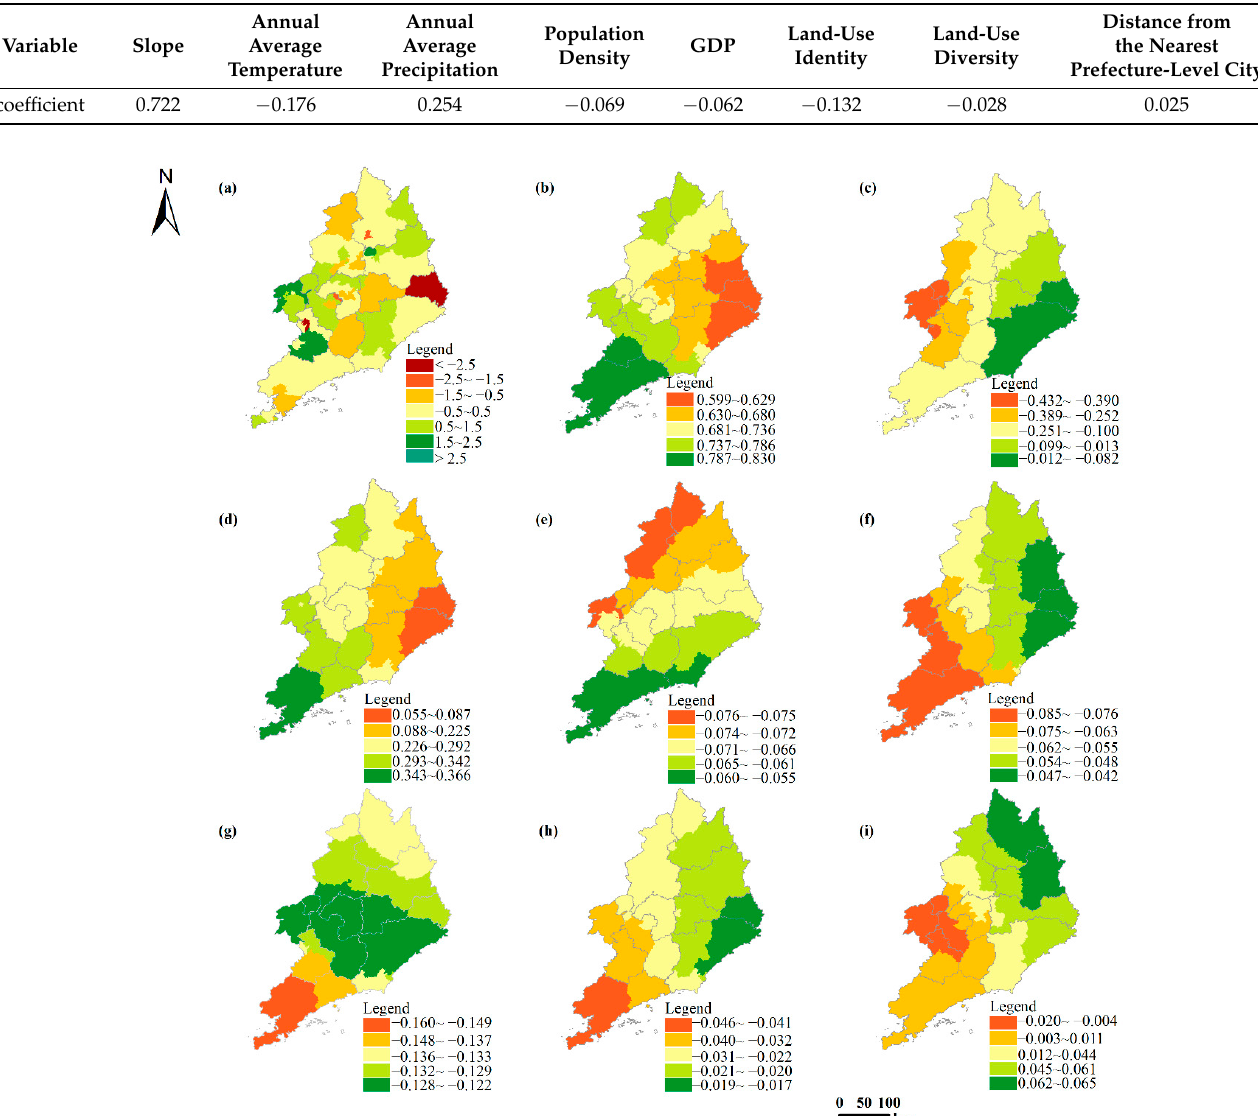
Figure 7. Spatial distribution of standardized residual and regression coefficients of driving factors for eco-environmental quality based on the MGWR model in the central and southern Liaoning urban agglomeration in 2010. ( a ) standardized residual; ( b ) slope; ( c ) annual average temperature; ( d ) annual average precipitation; ( e ) population density; ( f ) GDP; ( g ) land-use intensity; ( h ) land-use diversity; ( i ) distance from the nearest prefecture-level city.